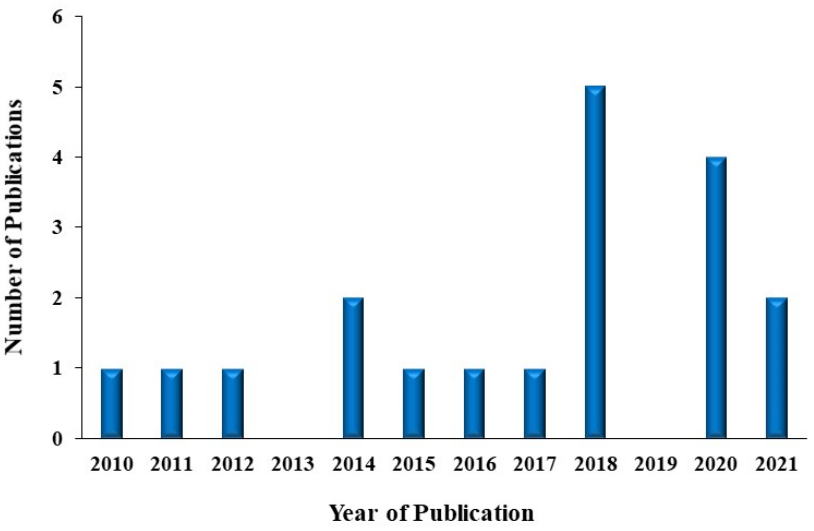
Figure 2. Number of publications for nanocarrier systems in taste masking per year.